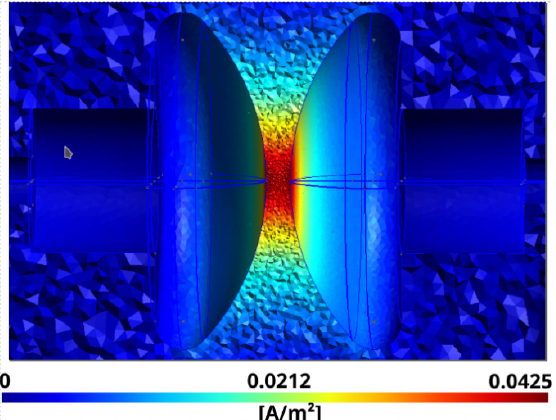
Figure 9. Module of the volumetric density of the displacement current 𝐽⃗ (cid:3031) corresponding to Equa- tion (4).